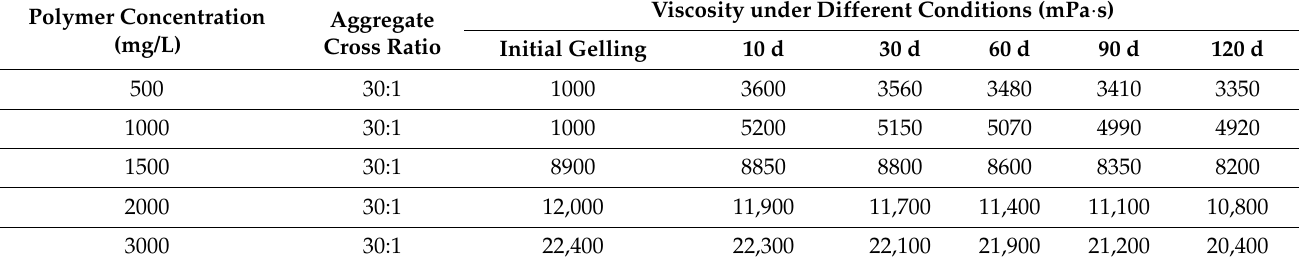
Table 6. Thermal stability evaluation results.